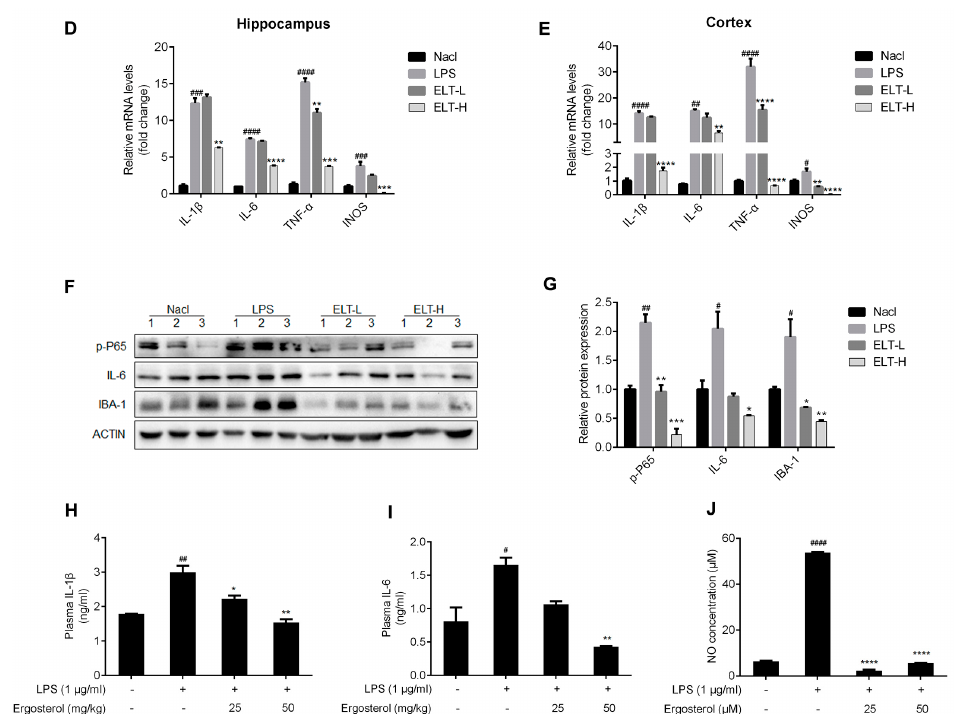
Figure 4. Ergosterol markedly decreased LPS-stimulated microglial activation and inflammation in ICR mice. ( A ) ICR mice were injected daily with Ergosterol (25 mg/kg, 50 mg/kg, i.p.) or vehicle (PBS, i.p.) for 5 days, followed by LPS (5 mg/kg, i.p.) or PBS injected for 24 h. The mice were then perfused and fixed. ( B , C ) An anti-IBA-1 antibody was used for immunohistochemistry. Quantification of IBA-1 fluorescence strength in the cerebral cortex or hippocampus (Nacl, n = 8 mice; LPS, n = 8 mice; Ergosterol 25 mg/kg + LPS is marked as ELT-L, n = 8 mice; Ergosterol 50 mg/kg + LPS is marked as ELT-H, n = 8 mice). ( D , E ) The mRNA levels of the IL-1 β , IL-6, TNF- α , and INOS inflammatory factors in the cortex and hippocampus of the mice were measured with qRT-PCR. ( F ) The p-P65, IL-6, and IBA-1 protein levels were determined by Western blot. Actin was used as a housekeeping control (Nacl, n = 3 mice; LPS, n = 3 mice; ELT-L, n = 3 mice; ELT-H, n = 3 mice). ( G ) The relative expression level of protein to actin was calculated by densitometry. ( H , I ) The protein levels of IL-1 β and IL-6 in plasma were detected by ELISA. ( J ) The expression levels of NO in plasma were detected with a Griess assay. Statistical significance was analyzed using one-way ANOVA and t test. # Significantly different from the control; * significantly different from the LPS-treated group. Significance: # p < 0.05, ## p < 0.01, ### p < 0.001, #### p < 0.0001, * p < 0.05, ** p < 0.01, *** p < 0.001, **** p <